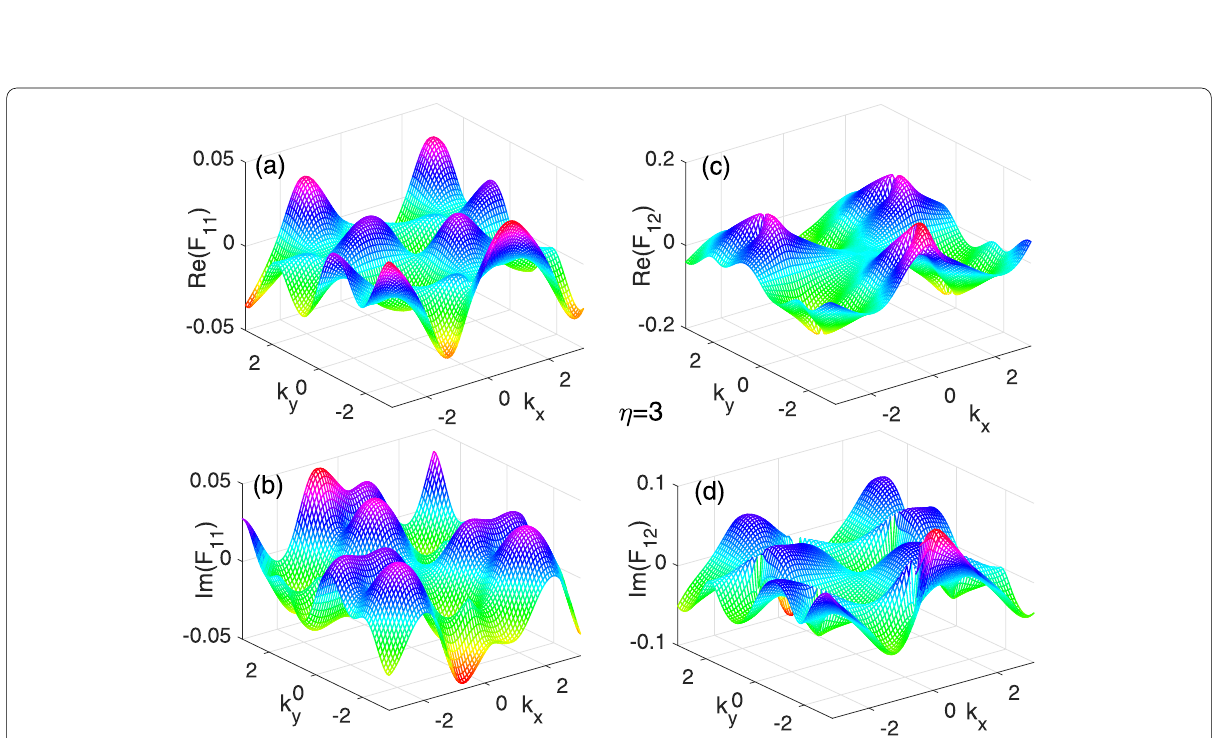
Fig. 5 (Color online): The complex Berry curvatures in the Brillouin zone for the parameter parameters η = 3 . a and b are the real and imaginary parts of the diagonal component of the complex Berry curvature F 11 , respectively. c and d are the real and imaginary parts of the off‑diagonal complex Berry curvature F 12 ,